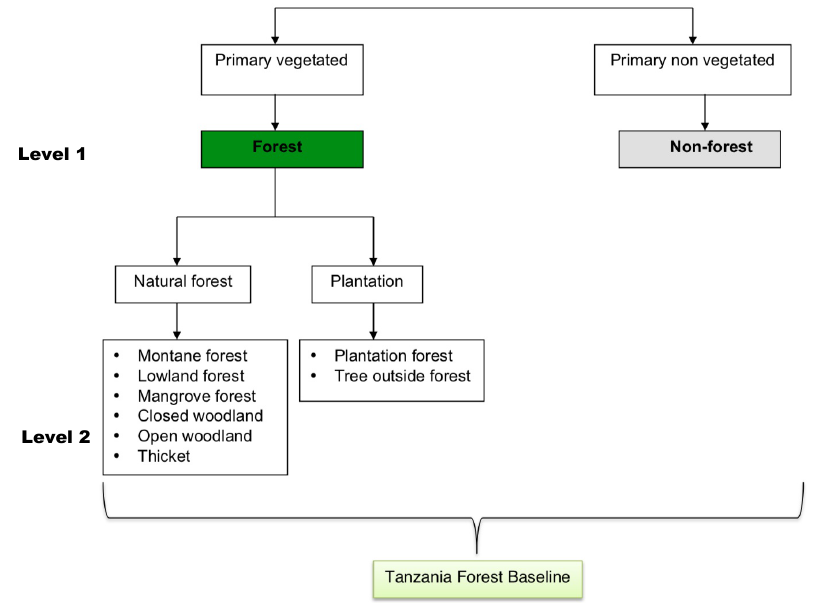
Figure 2. Forest baseline classification hierarchical